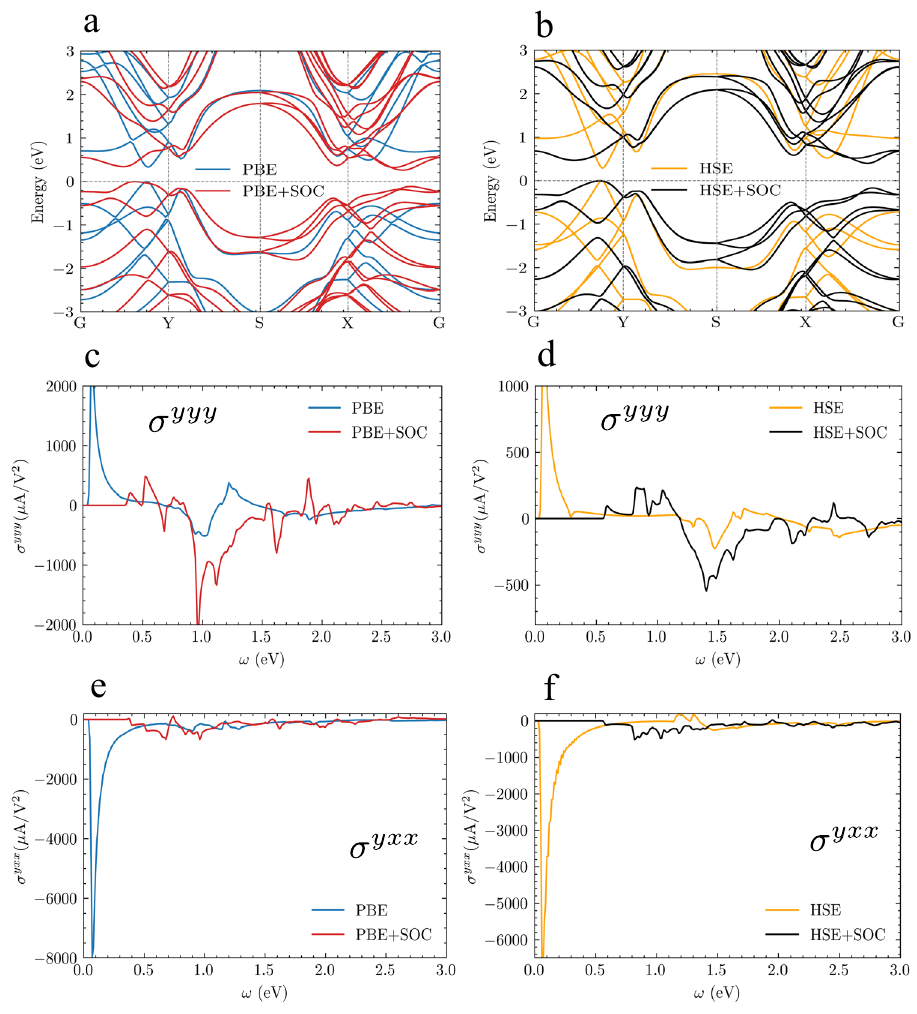
Fig. 8 Electronic band structures and shift current spectra of monolayer Bi. Band structures computed with a PBE and PBE + SOC and b HSE and HSE + SOC. σ yyy spectra computed with c PBE and PBE + SOC and d HSE and HSE + SOC. σ yxx spectra computed with e PBE and PBE + SOC and f HSE and HSE +